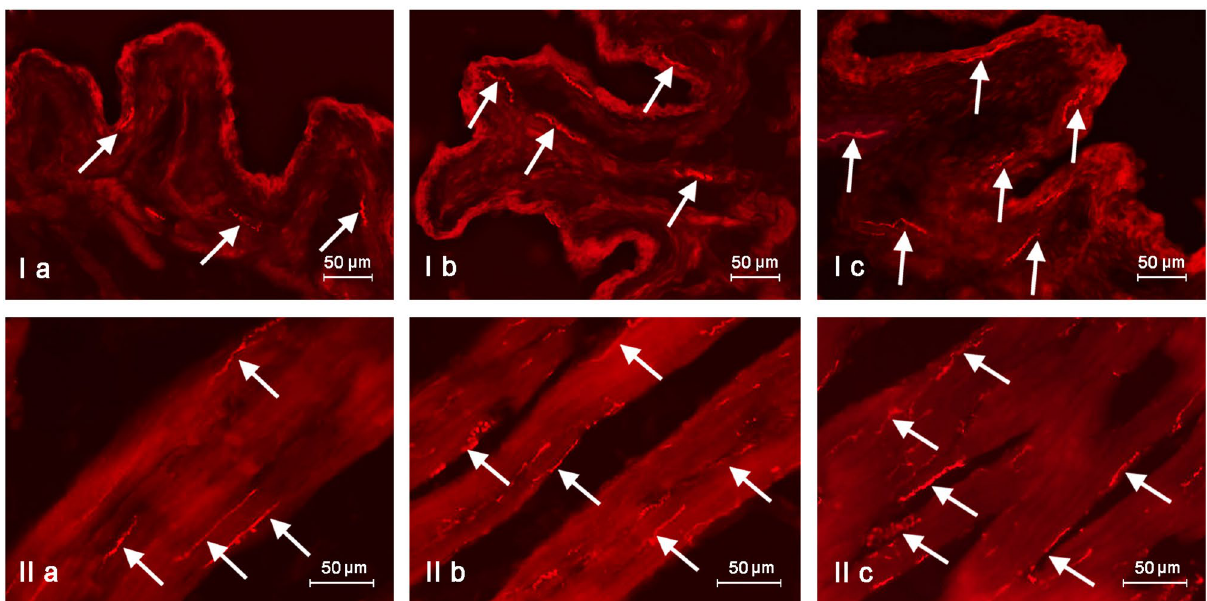
Figure 3. Nerves immunoreactive to vasoactive intestinal polypeptide (VIP) in the mucosal (I) and muscular (II) layers of the porcine urinary bladder trigone under physiological conditions ( a ), under the influence of BPA in a dose of 0.05 mg/kg b.w./day ( b ) and under the influence of BPA in a dose of 0.5 mg/kg b.w./day ( c ). VIP— positive nerves are marked with